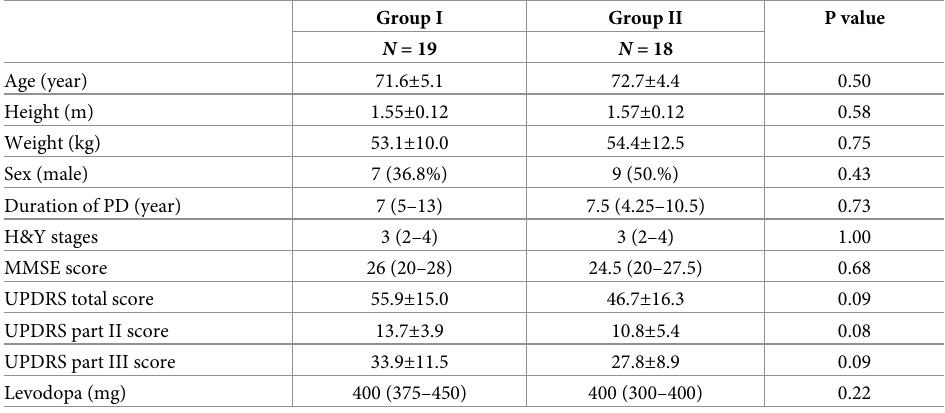
Table 1. Subjects’ clinical